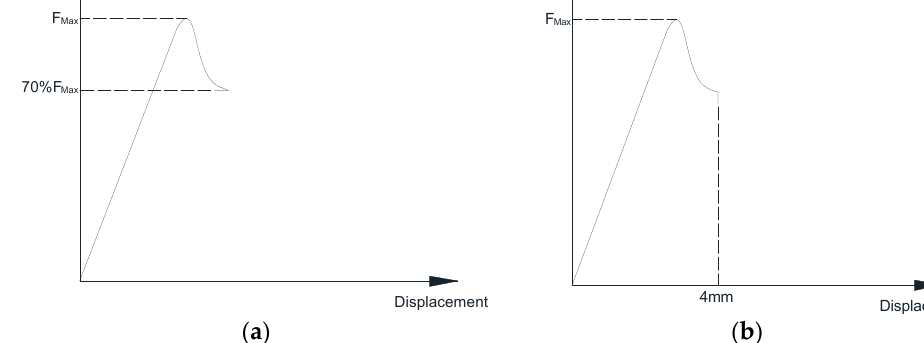
Figure 4. Termination rule for the short-beam shear test. ( a ) Drop to 30% of the maximum load; ( b ) Maximum displacement of 4 mm.